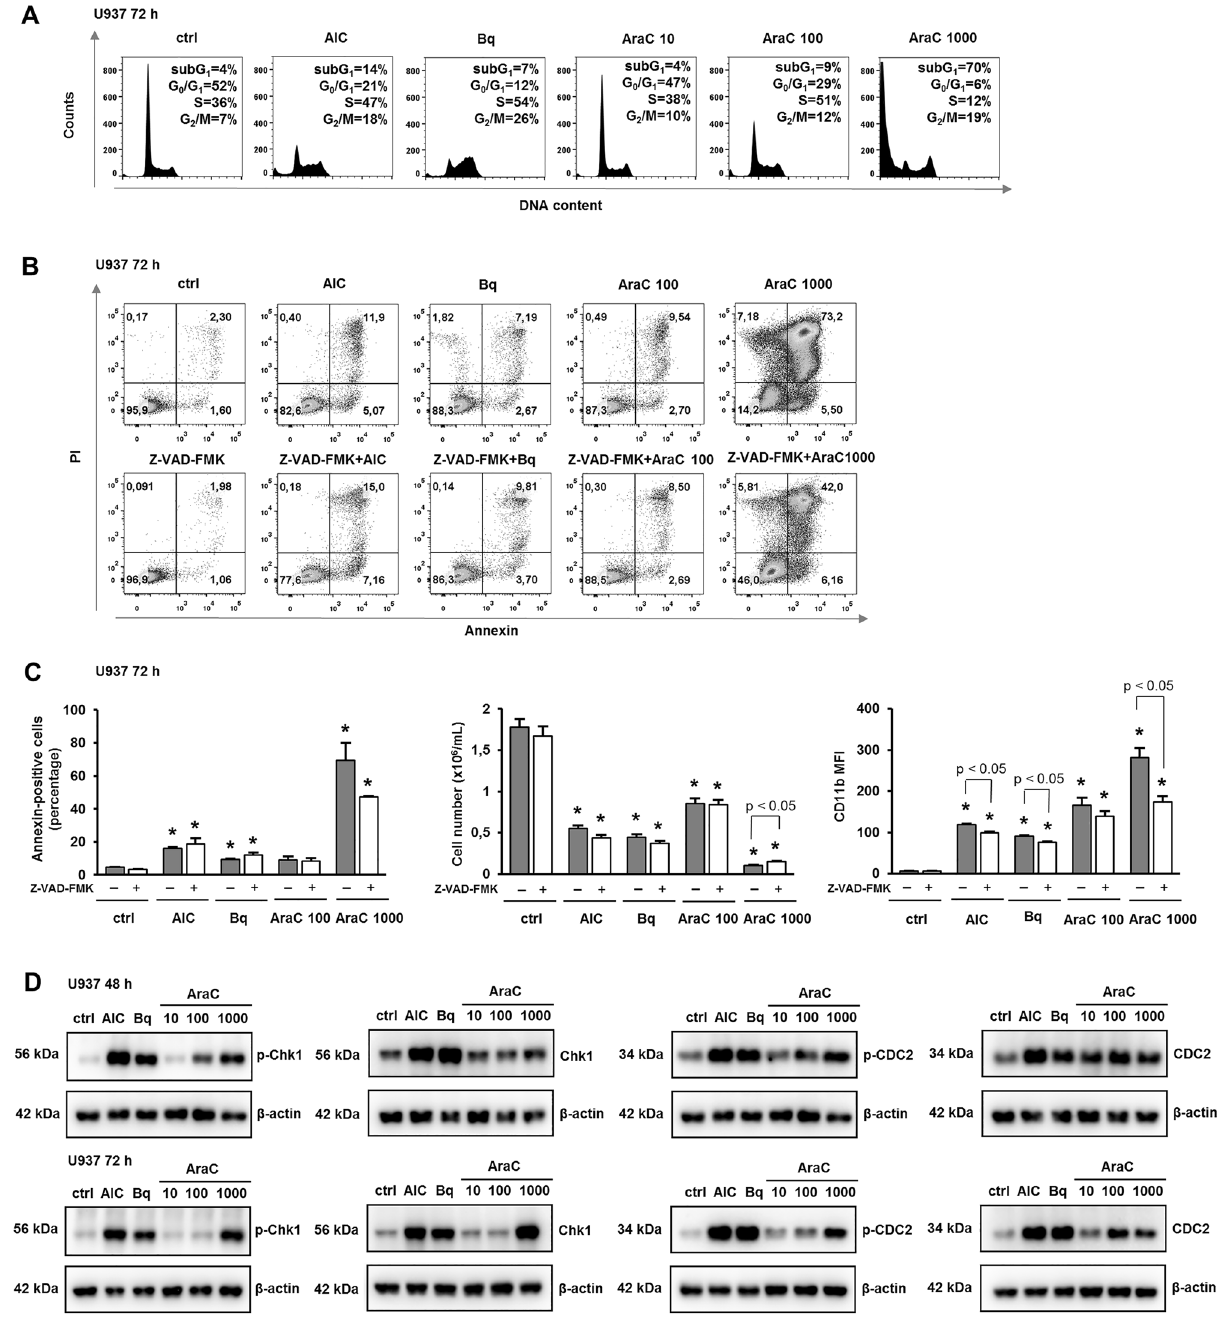
Figure 2. Cytarabine induces cell cycle arrest and activates Chk1. U937 cells were incubated with AICAr (AIC) (0.2 mM), brequinar (Bq) (0.5 µM) and AraC (10, 100, 1000 nM). ( A ) Representative histograms of propidium-labelled cells from three independent experiments analyzed by flow cytometry. ( B, C ) Pan-caspase inhibitor Z-VAD-FMK (10 μM) was added 30 min before the addition of agents. ( B ) The representative dot plots of cells stained with annexin V-FITC/PI and analyzed by flow cytometry. ( C ) The percentage of annexin V-FITC-positive cells, the number of viable cells and the expression of differentiation markers were determined after 72 h. Results are mean ± S.E. (error bars) of at least three independent experiments. *, p < 0.05 (Student’s t-test) compared with control (ctrl). ( D ) U937 cells were incubated with AICAr (AIC) (0.2 mM), brequinar (Bq) (0.5 µM) and AraC (10, 100, 1000 nM) for 48 h (upper panels) or 72 h (lower panels). Total cell lysates were isolated after 48 and 72 h and analyzed by Western blotting for the level of Ser-345-phosphorylated Chk1, total Chk1, Tyr-15-phosphorylated CDC2 and total CDC2. Representative immunoblots from three independent experiments are